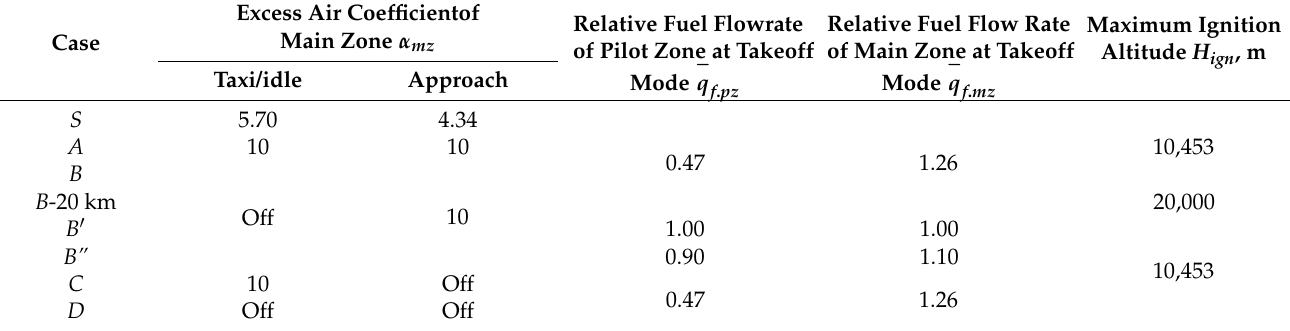
Table 8. Cases for reducing CO